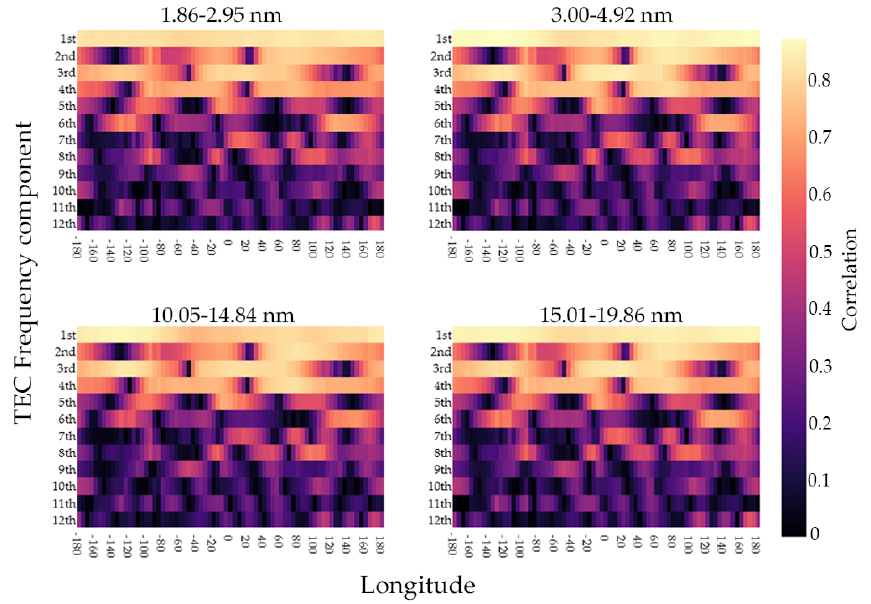
Figure 8. Correlation heat map of 5 years of data for photon flux at geomagnetic latitude 22.5 ◦ S. TEC frequency components range from 0 to 0.25